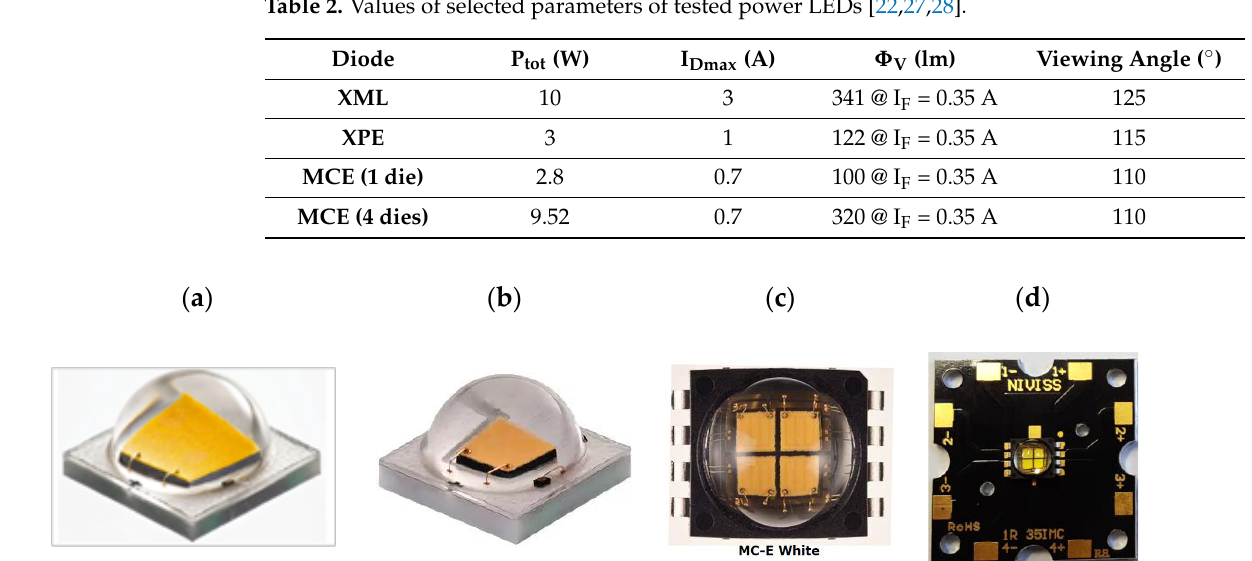
Table 2. Values of selected parameters of tested power LEDs [22,27,28].